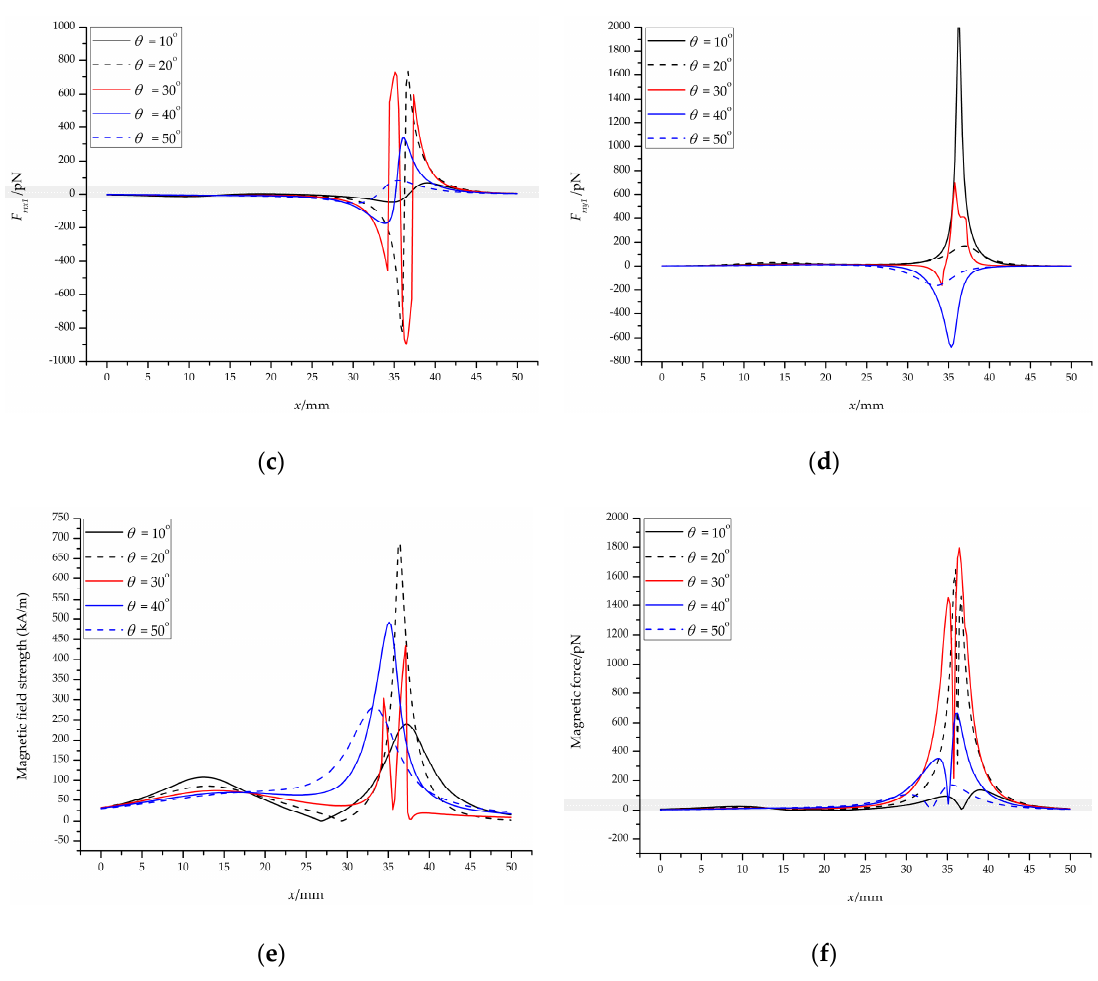
Figure 6. The results of the inclined magnetic field: The magnetic field strength ( a ) in the x -direction and ( b ) in the y -direction; the magnetic force ( c ) in the x -direction and ( d ) in the y -direction; ( e ) the total magnetic field strength and ( f ) the total magnetic force at the center of the channel.